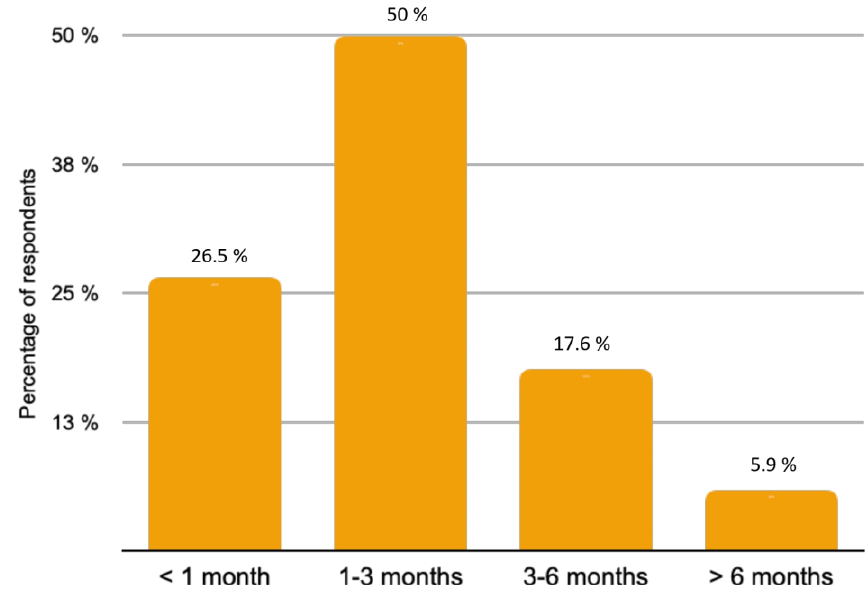
Figure 4. Delay time for obtaining BRCA germline mutation results.